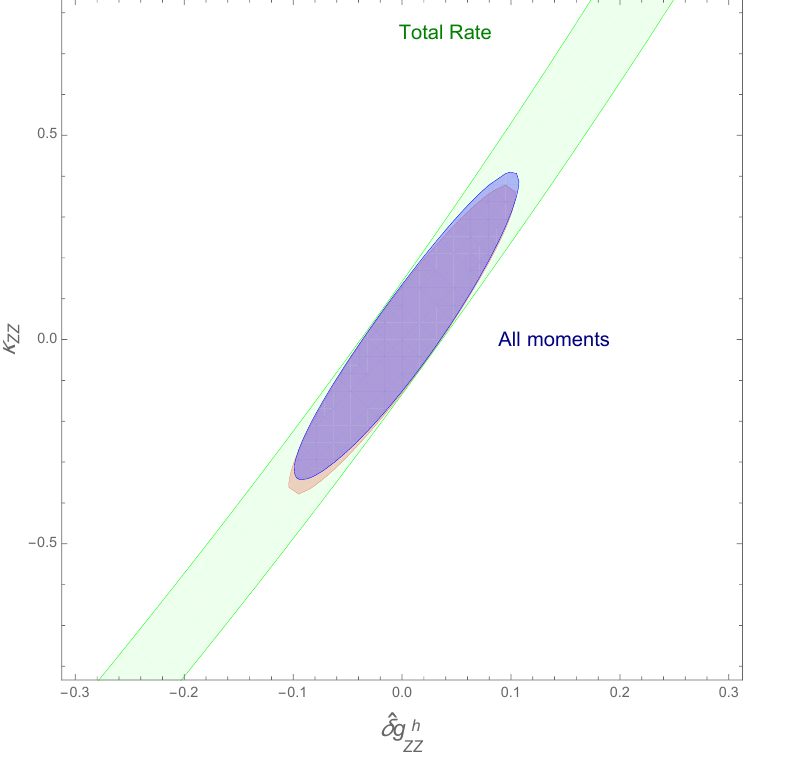
Figure 5 . Bounds at 68 % CL on the CP -even anomalous couplings. The green band shows the bound from the total rate which keeps a flat direction, κ ZZ ≈ 3 . 7 δ ˆ g h ellipse shows our final bounds including all the angular moments. The red ellipse also shows the results of an angular moment analysis but considering only the interference between the EFT and SM